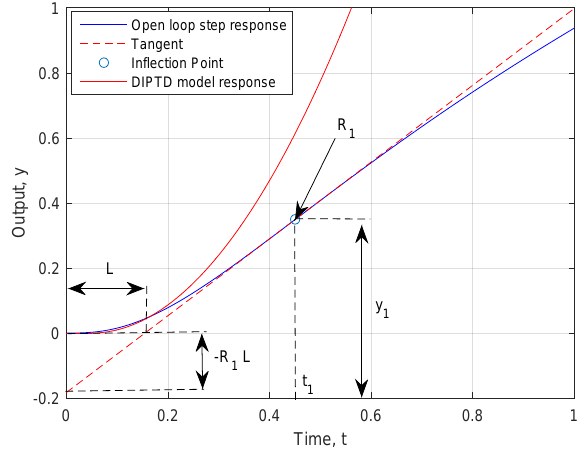
Figure 2: E1. The figure illustrates the model reduc- tion technique. Shows the open loop step response of the higher order process model given in column 2 in Table 2. Shows the step response of the DIPTD model, H p ( s ) = K e − τs , approximation where the gain accel- s 2 eration K = R 1 and time delay τ = L L 2 π (Mode 1). R 1 is the unit reaction rate and L is Ziegler’s lag and ( t 1 , y 1 ) is the inflection point. Figure 3: E1. The figure illustrates the model reduc- tion technique. Shows the magnitude re- sponses for the higher order process model in column 2 in Table 2 and the DIPTD model, H p ( s ) = K e − τs , approximation where the s 2 gain acceleration K = ζ R 1 varies, i.e. ζ ∈ L { 0 . 1 , 1 , 10 }